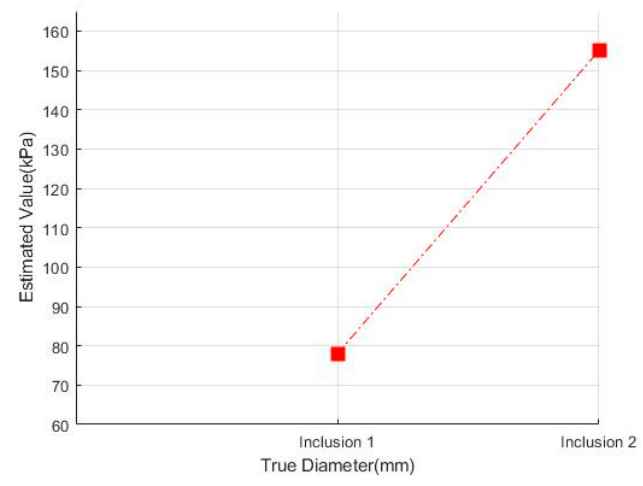
Figure 32. Z-score graph by